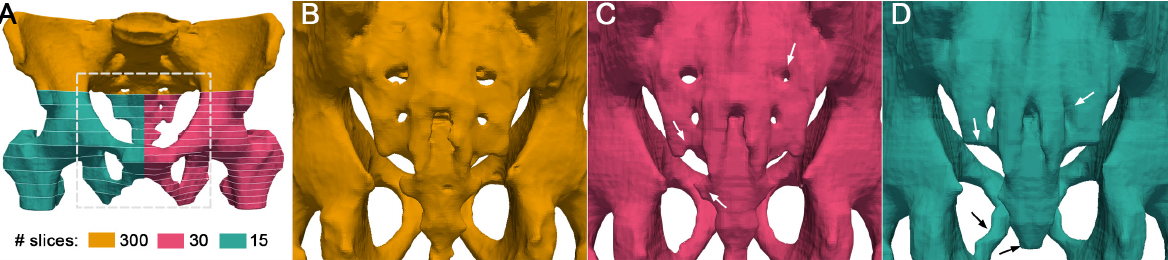
Figure 4. Effects of downsampling on the human pelvis example: ( A ) a visual comparison of the reconstruction using all the slices (top, orange) versus a downsampling of 10% (30/300 slices used) (bottom right, pink) and a downsampling of 5% (15/300 slices used) (bottom left, blue). The dotted white square marks the region where we extract the detail for ( B – D ) after flipping the view for better visualization; ( B ) reconstruction of the coccyx without downsampling; ( C ) downsampling of 10%; and ( D ) 5%, respectively. Arrows on ( C , D ) highlight the loss of features with respect to ( B ) due to downsampling.